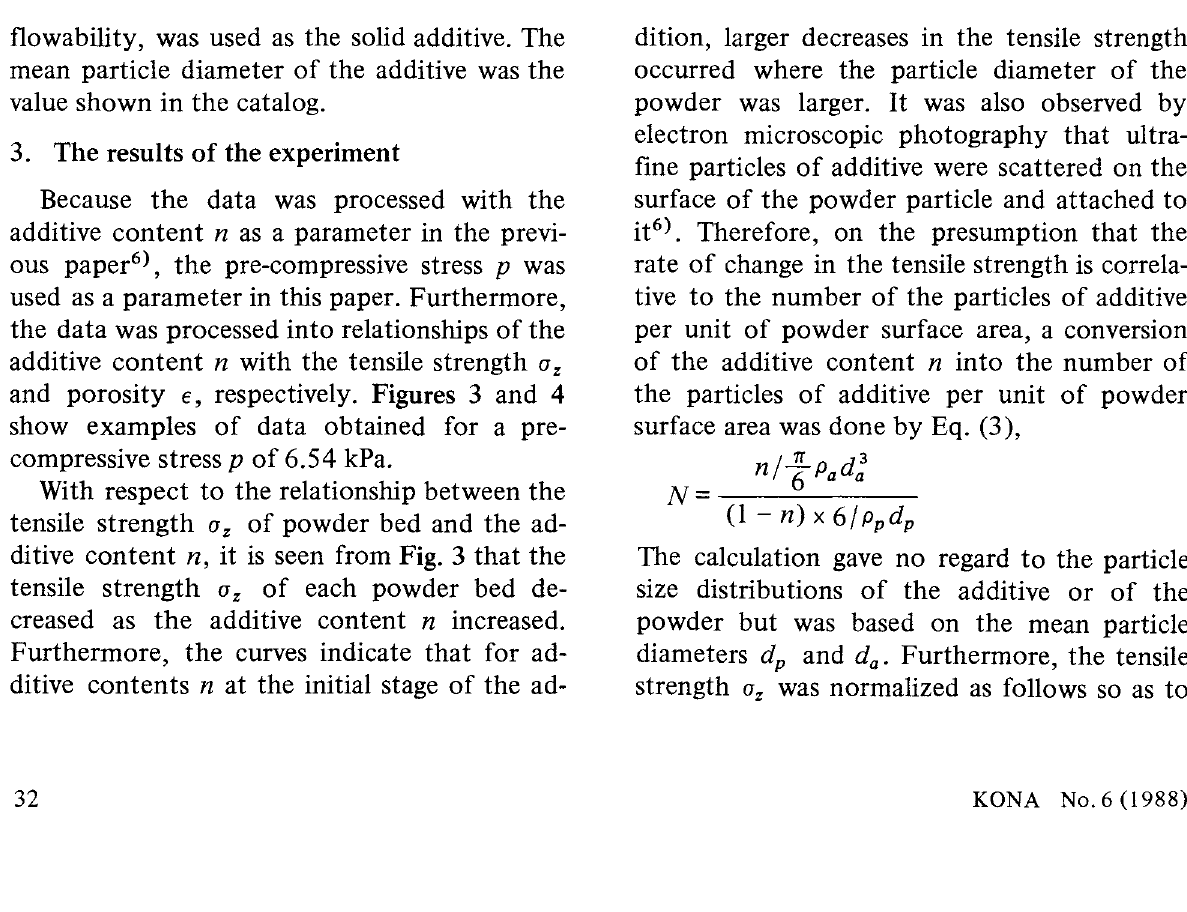
Fig. 4 Relationship between porosity of powder bed and additive